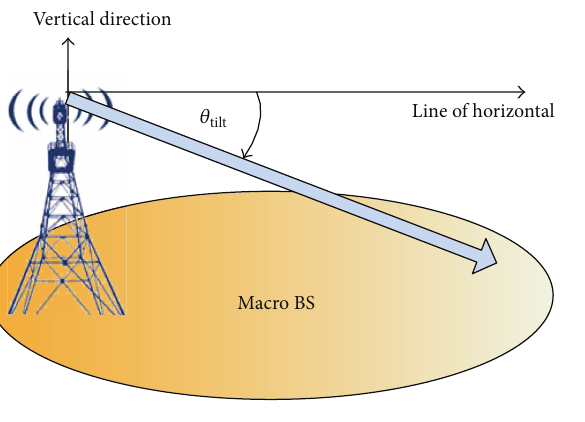
Figure 3: Electrical downtilt.